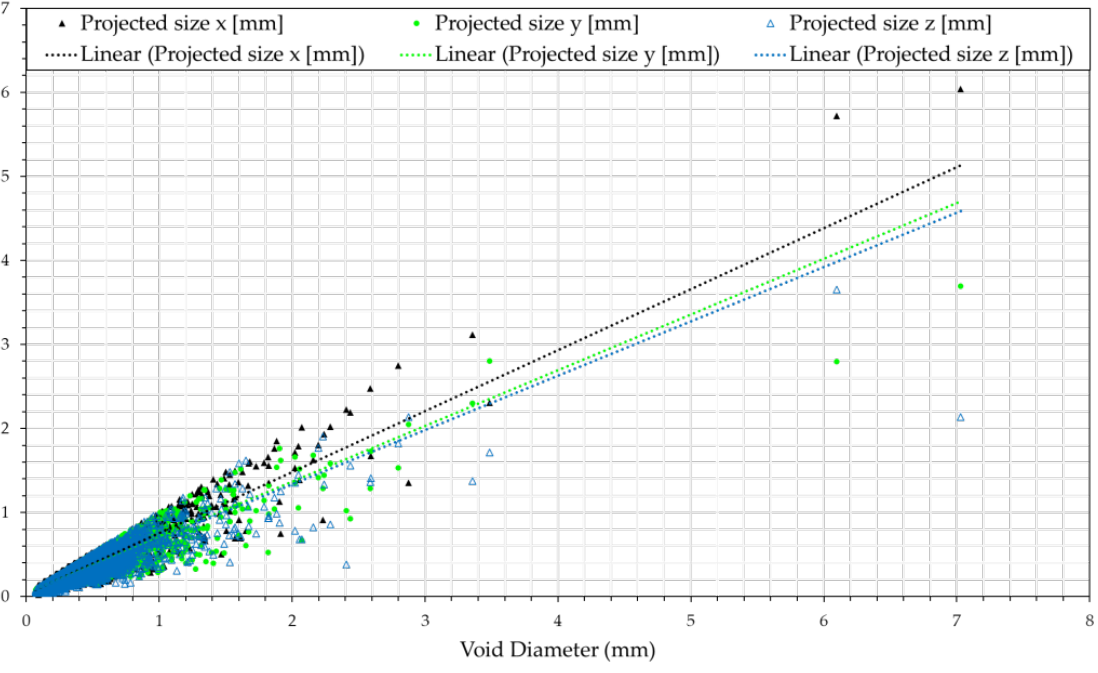
Figure 10. CAST-3DCP void topology from μ -CT scanning. The coefficients of determination (R 2 ) for x, y and z linear regression are 0.84, 0.85 and 0.83, respectively.